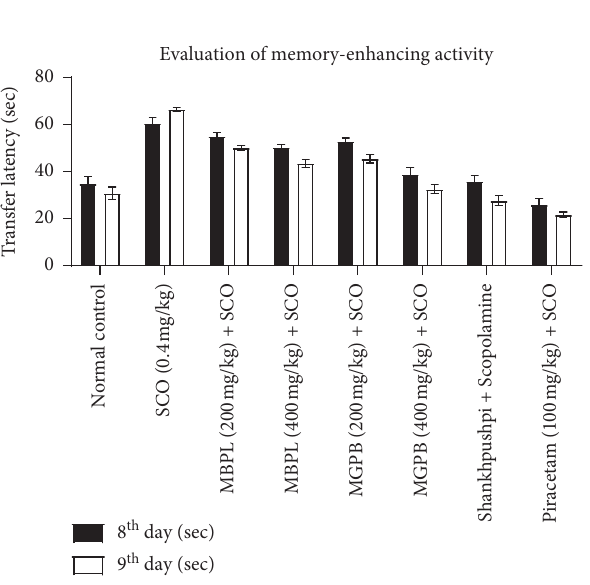
Figure 2: Bar diagram comparing the memory-enhancing activity of B. pinnatum leaves and G. pinnata barks with standard drug Piracetam and Shankhpushpi in the terms of transfer latency (SCO: Scopolamine, MBPL: Bryophyllum pinnatum leaves methanol ex- tract, MGPB: Garuga pinnata bark methanolic